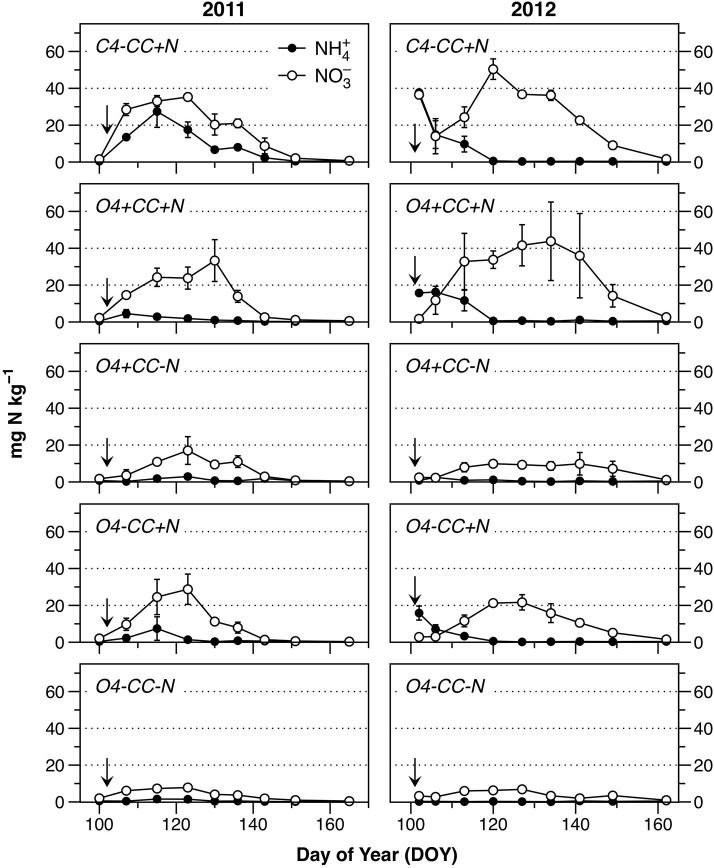
Content of NH4+ (filled circles) and NO3- (open circles) in the soil during the monitored periods in 2011 and 2012. Fertilization took place on April 12 (DOY102) in 2011 and April 10 (DOY101) in 2012 (indicated by the arrows). The data represent means of four observations in two replicate plots, while error bars represent standard error (n = 2).